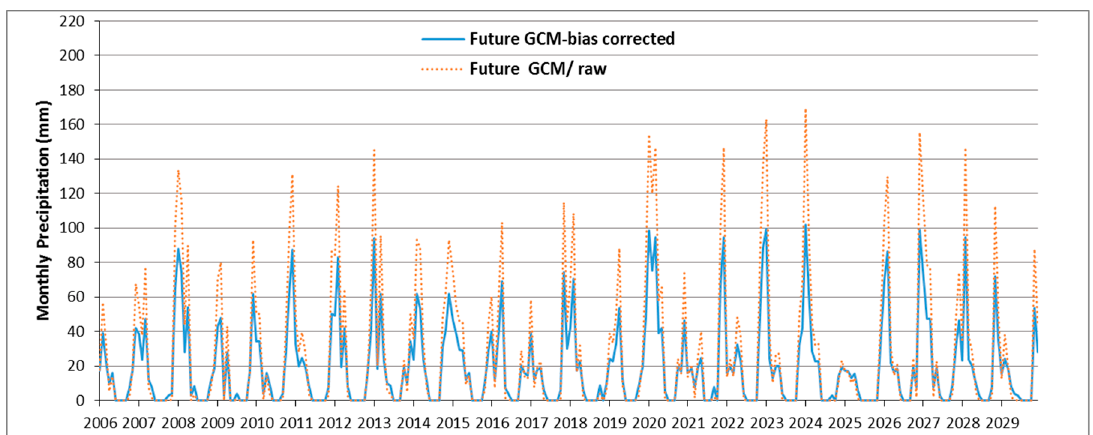
Figure 7. Empirical CDF for daily precipitation for reference raw GCM (1977–2005), future raw GCM for the RCP4.5 scenario (2006–2029) and QM- bias-corrected data at Nouroozloo station for March and December.